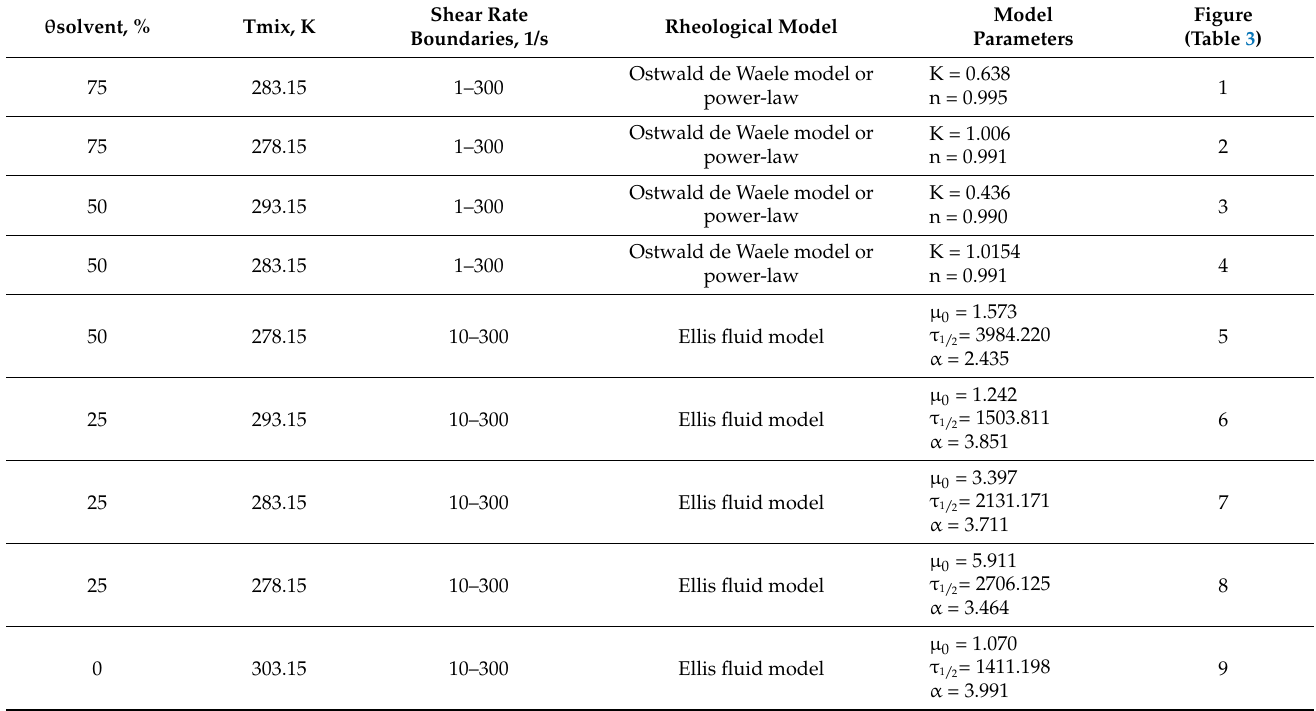
Table 9. Results of experimental studies on rheological properties of the bituminous and low-viscosity oil mixture of the Ashal’chin